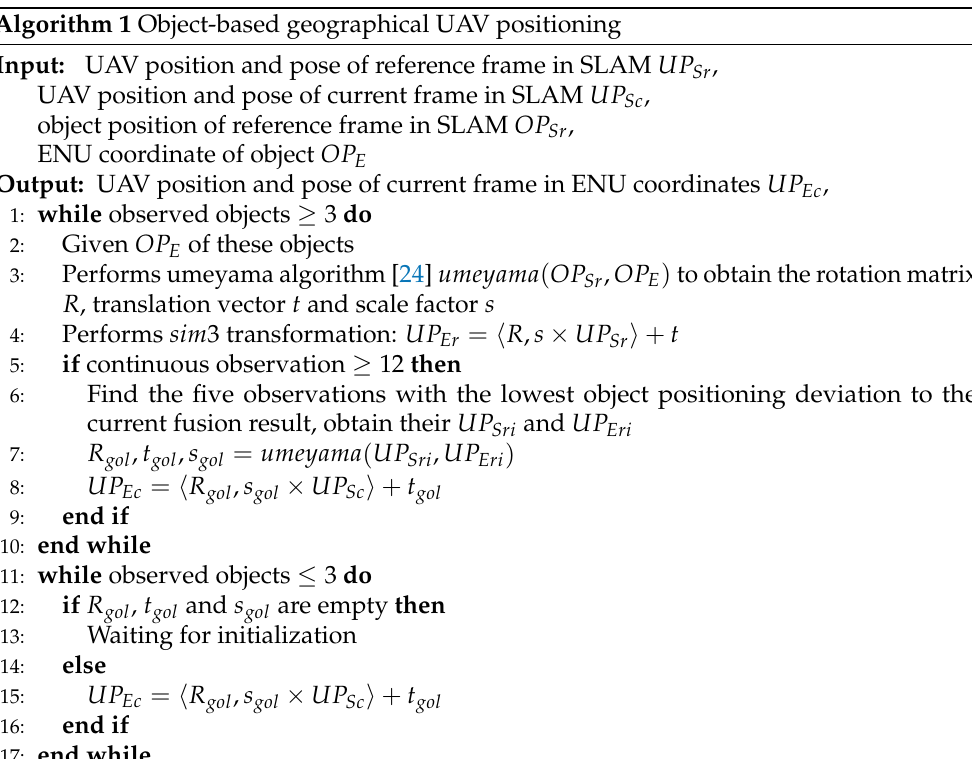
Algorithm 1 Object-based geographical UAV